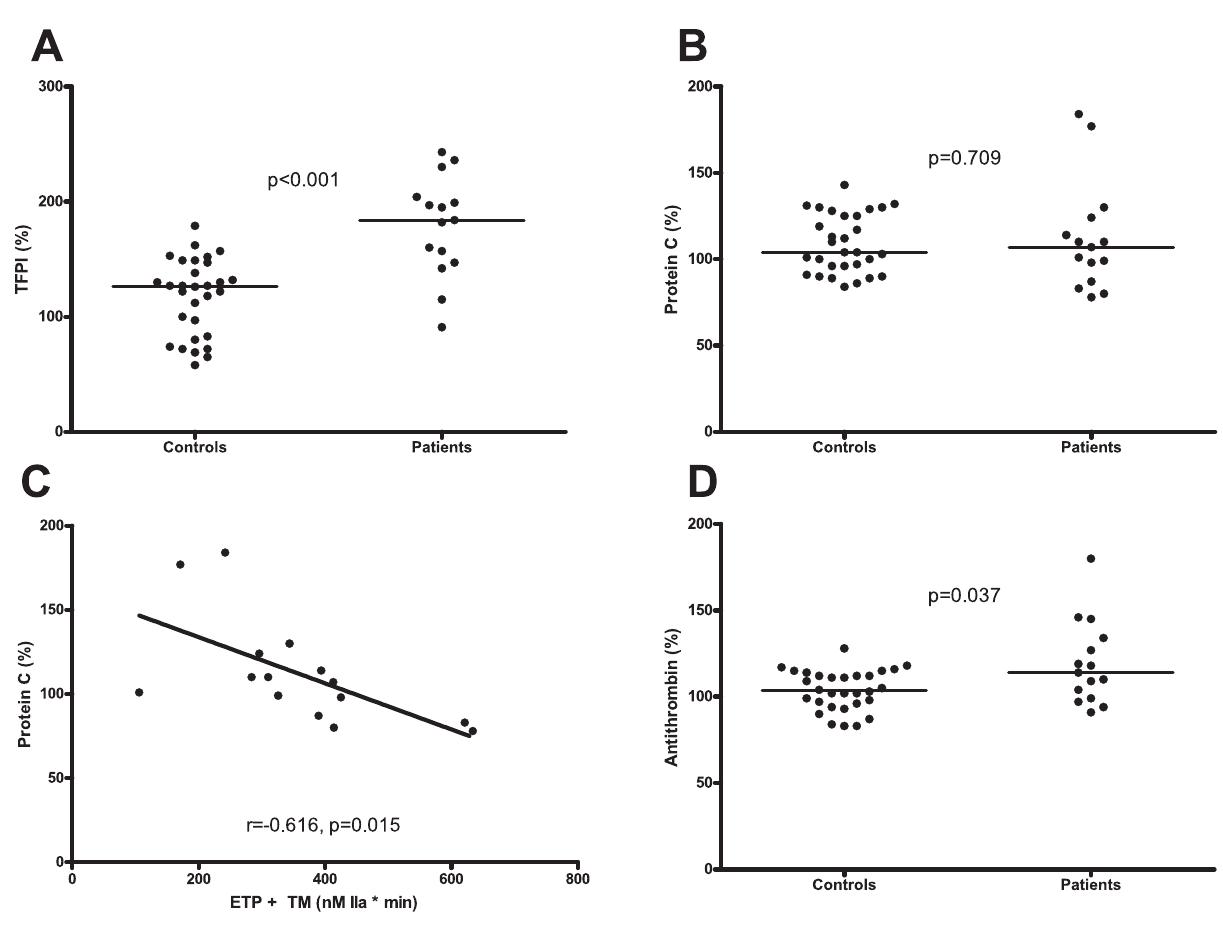
Figure 4. Coagulation factor levels in patients and healthy controls. A . Plasma levels of TFPI in patients and healthy controls. B . Protein C levels in plasma from patients and healthy controls. C . Correlation between the Endogenous Thrombin Potential (ETP) measured in the presence of thrombomodulin (TM) and plasma levels of protein C in patients. D . Antithrombin (AT) levels in plasma from patients and healthy controls. Horizontal bars indicate medians.